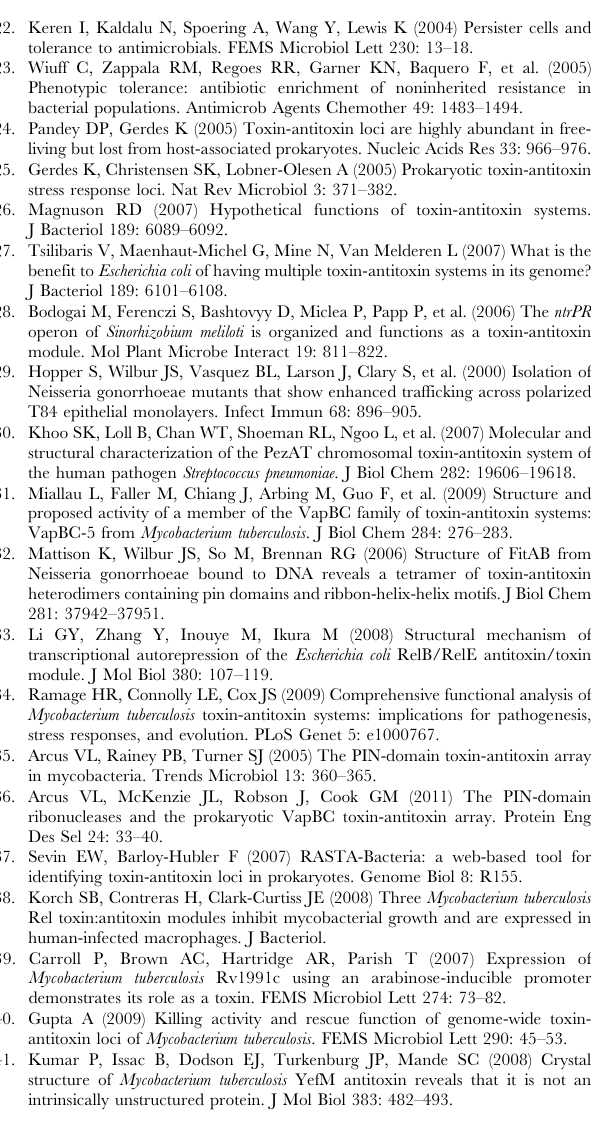
Figure S2 Phylogenetic tree of VapC proteins from mycobacteria. VapCs were aligned using ClustalW2 multiple sequence and server alignment server (http://www.ebi.ac.uk/ Tools/clustalw2/index.html). The tree was generated in Jalview 2.08.1 based on percentage identity between sequences. Table S1 Properties of mycobacterial vapBC toxin-antitoxin modules selected for study. Table S2 VapC toxicity in M. smegmatis mc 2 155 assessed by transformation efficiency of VapC expression vector. Table S3 VapC toxicity in Mtb assessed by transformation efficiency of VapC expression vector. Table S4 Strains and plasmids used in this study.